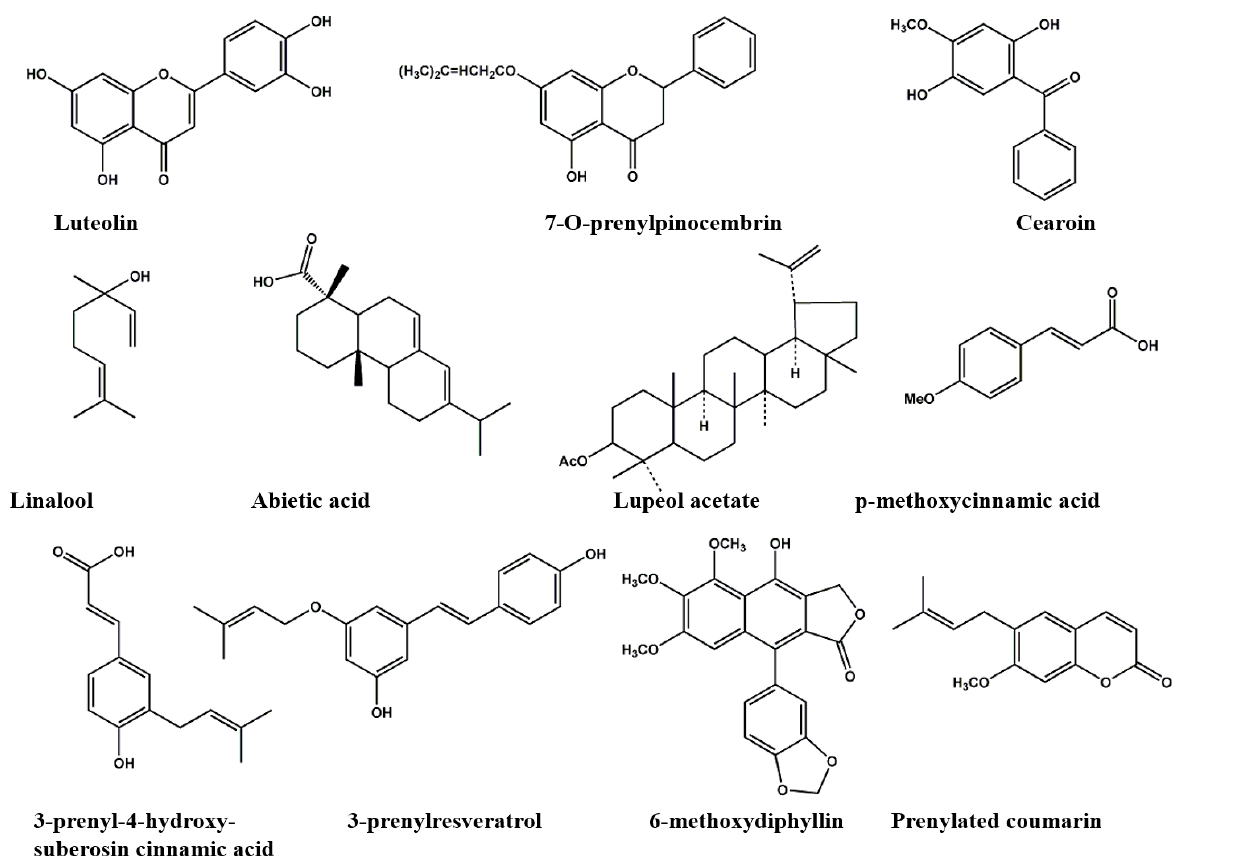
Figure 3. Representative chemical components identified in propolis since